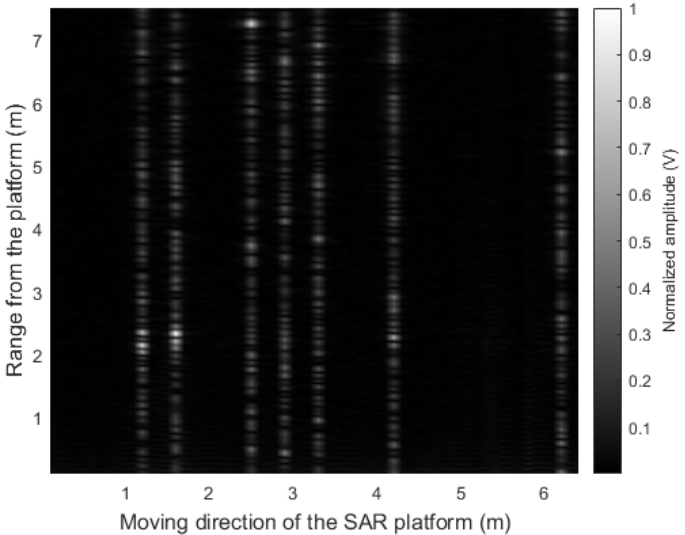
Figure 10. SAR image reconstruction result: when the CS-based signal recovery is applied to the sensor data in which the I/Q components are combined.